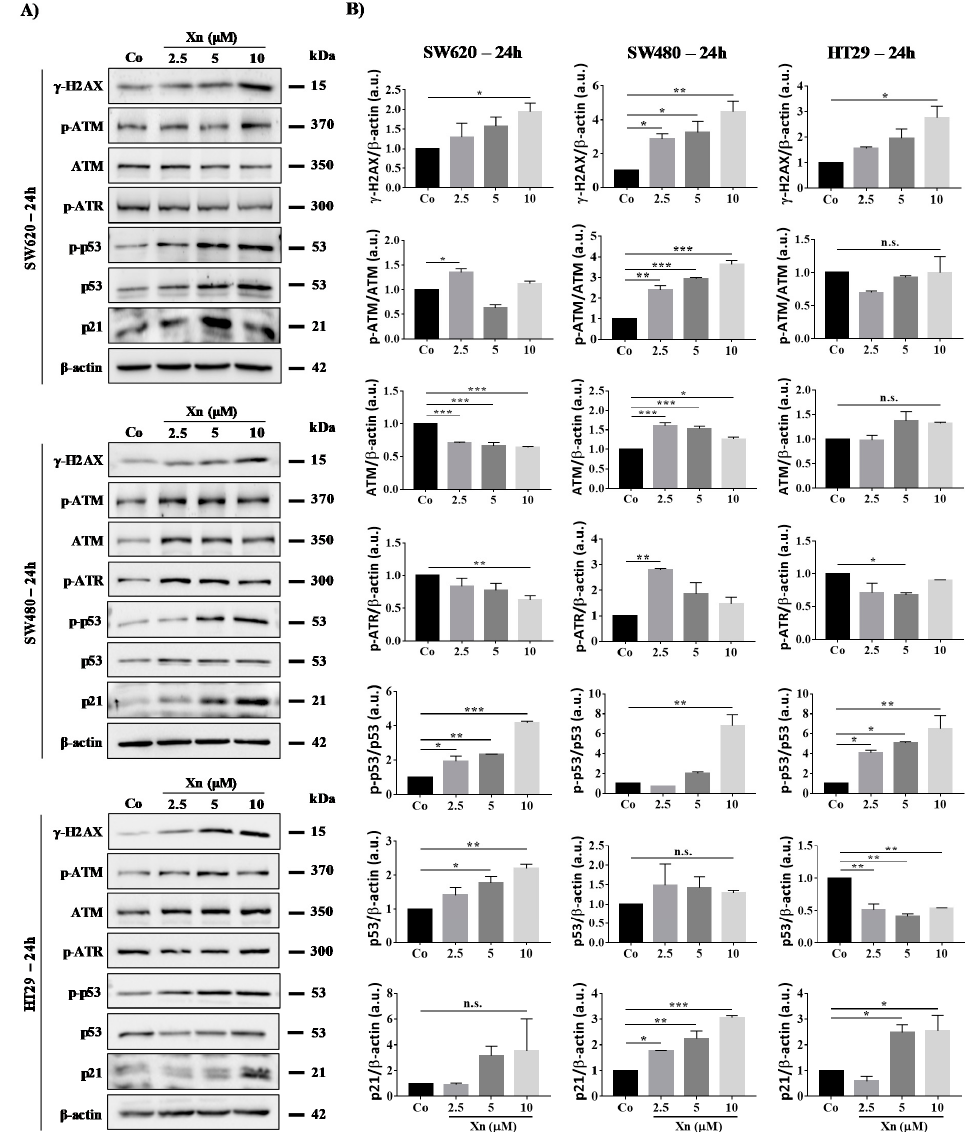
Figure 5. Xanthohumol (Xn) induces a DNA damage pathway in colon cancer cell lines after 24 h of treatment. ( A ) Immunoblotting analysis of phosphorylated H2AX, phospho-ATM, ATM, phospho-ATR, phospho-p53, p53, and p21 in the three colon cancer cell lines SW620, SW480, and HT29. Cells were incubated with increasing concentrations of Xn (0, 2.5, 5, and 10 µM) for 24 h ( A ). β -actin: loading control. One representative example of three independent experiments. ( B ) Densitometry quantification of western blotting obtained in Figure 5A. Data are expressed as mean fold induction ± SEM of three independent experiments. p values were determined by a one-way ANOVA followed by Tukey’s multiple comparison test. * p < 0.05, ** p < 0.01, and *** p < 0.001.